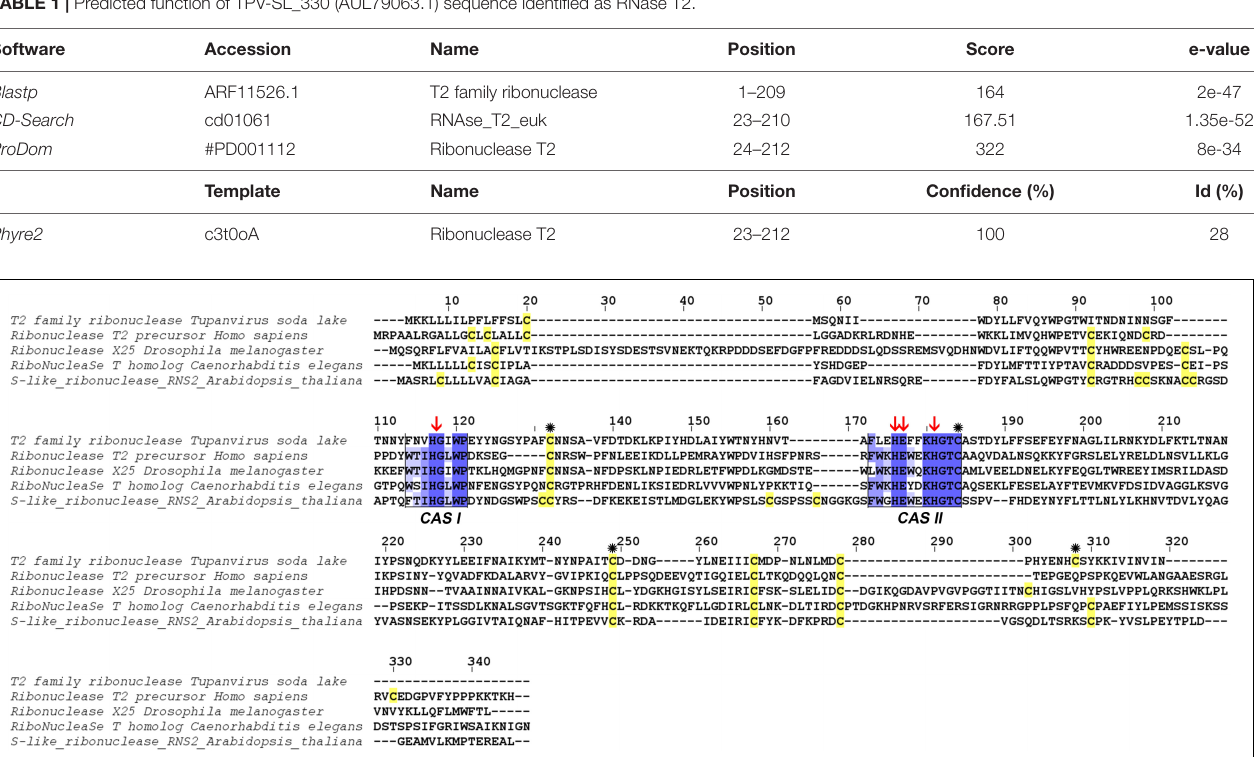
TABLE 1 | Predicted function of TPV-SL_330 (AUL79063.1) sequence identified as RNase T2.